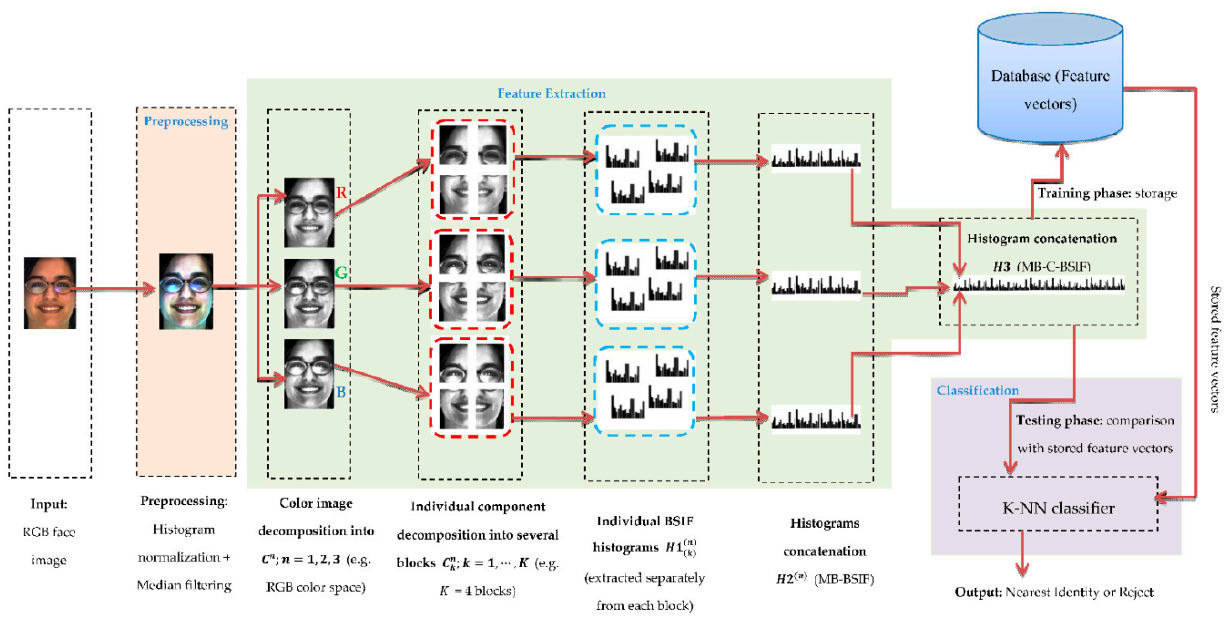
Figure 1. Schematic of the proposed Single-Sample Face Recognition (SSFR) system based on the Multi-Block Color- Binarized Statistical Image Features (MB-C-BSIF)